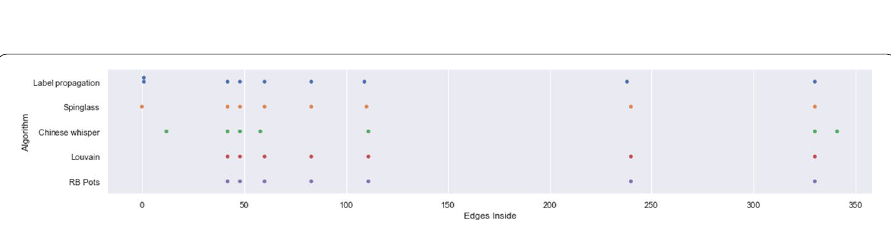
Fig. 9 Comparison of the size of the edges inside the five